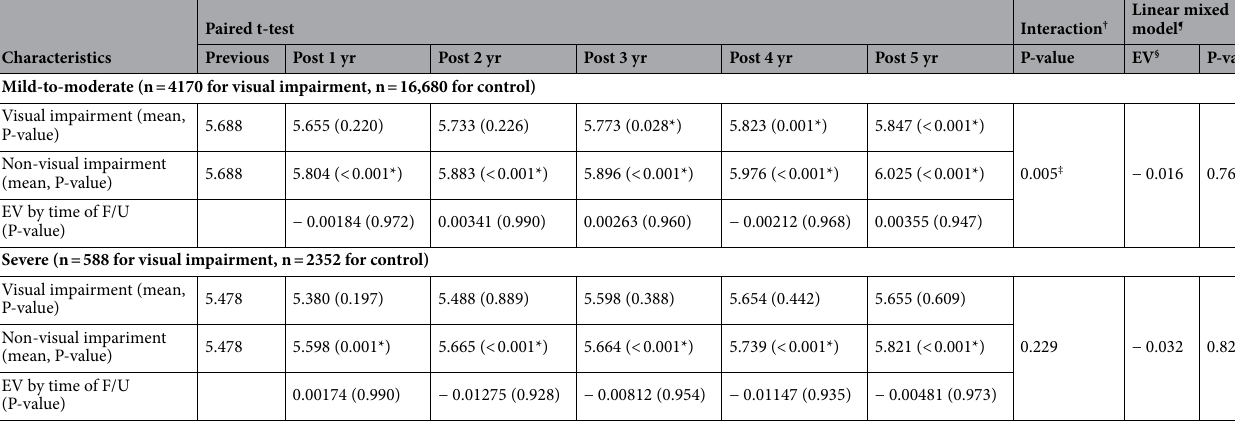
Table 3. Difference in mean values of income between initial value and post 5-year values of visual impairment in visual impairment and non- visual impairment groups by severity of disability. EV, Estimated value; CCI, Charlson Comorbidity Index. *Paired t-test based on previous income, significance at P < 0.05. † Interaction effects between time and group. ‡ Interaction effects by linear mixed model, significance at P < 0.05. § Estimated value of linear mixed model for visual impairment group based on control group. ¶ Fixed